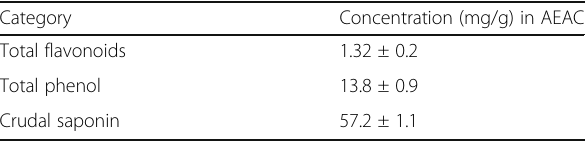
Table 1 The concentration of three bioactive compounds, total phenols, flavonoids and crudal saponins in AEAC